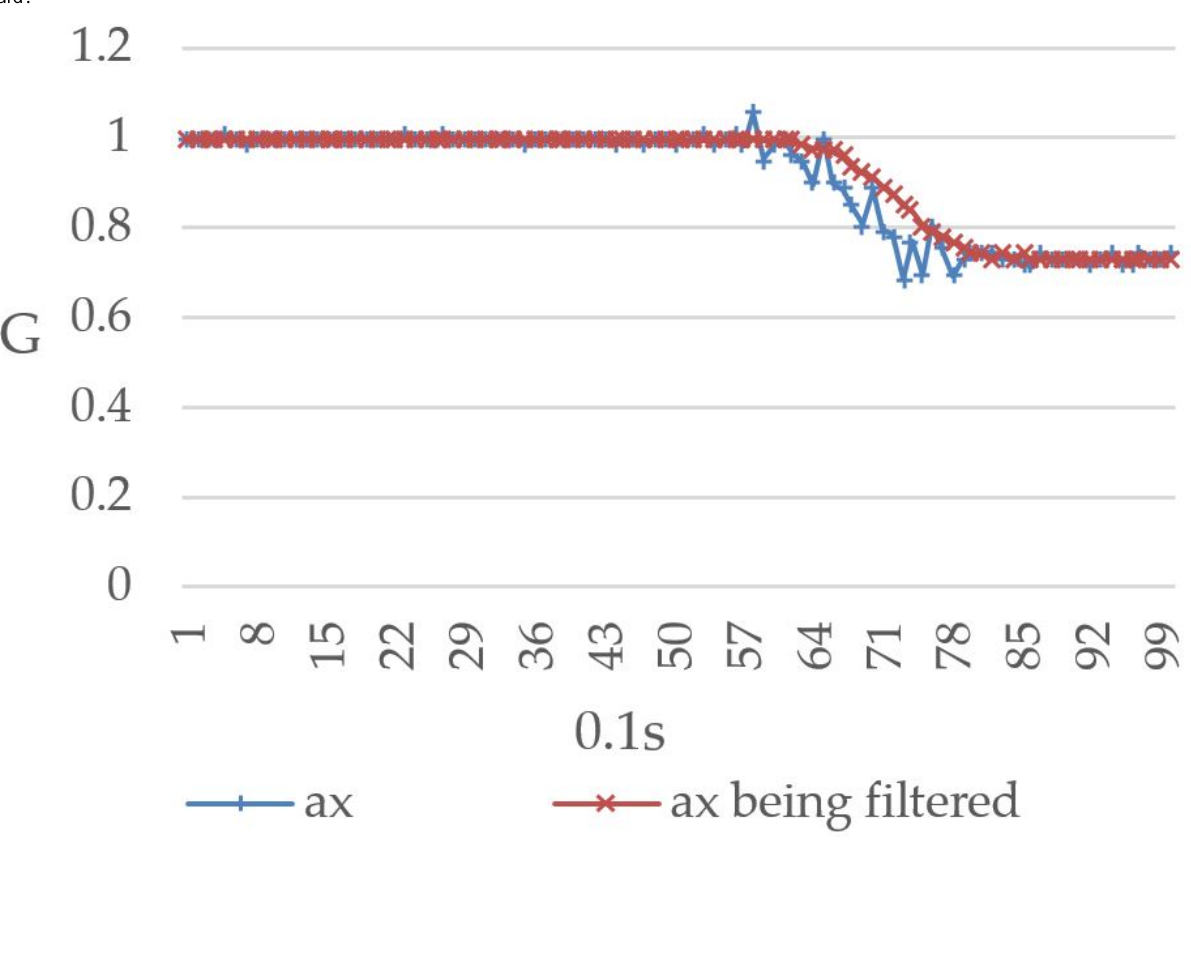
Figure 12. Triple axis accelerometer's pre-filtered x -axis values (ax) and filtered x -axis values (ax being filtered) when the user's body was tilted